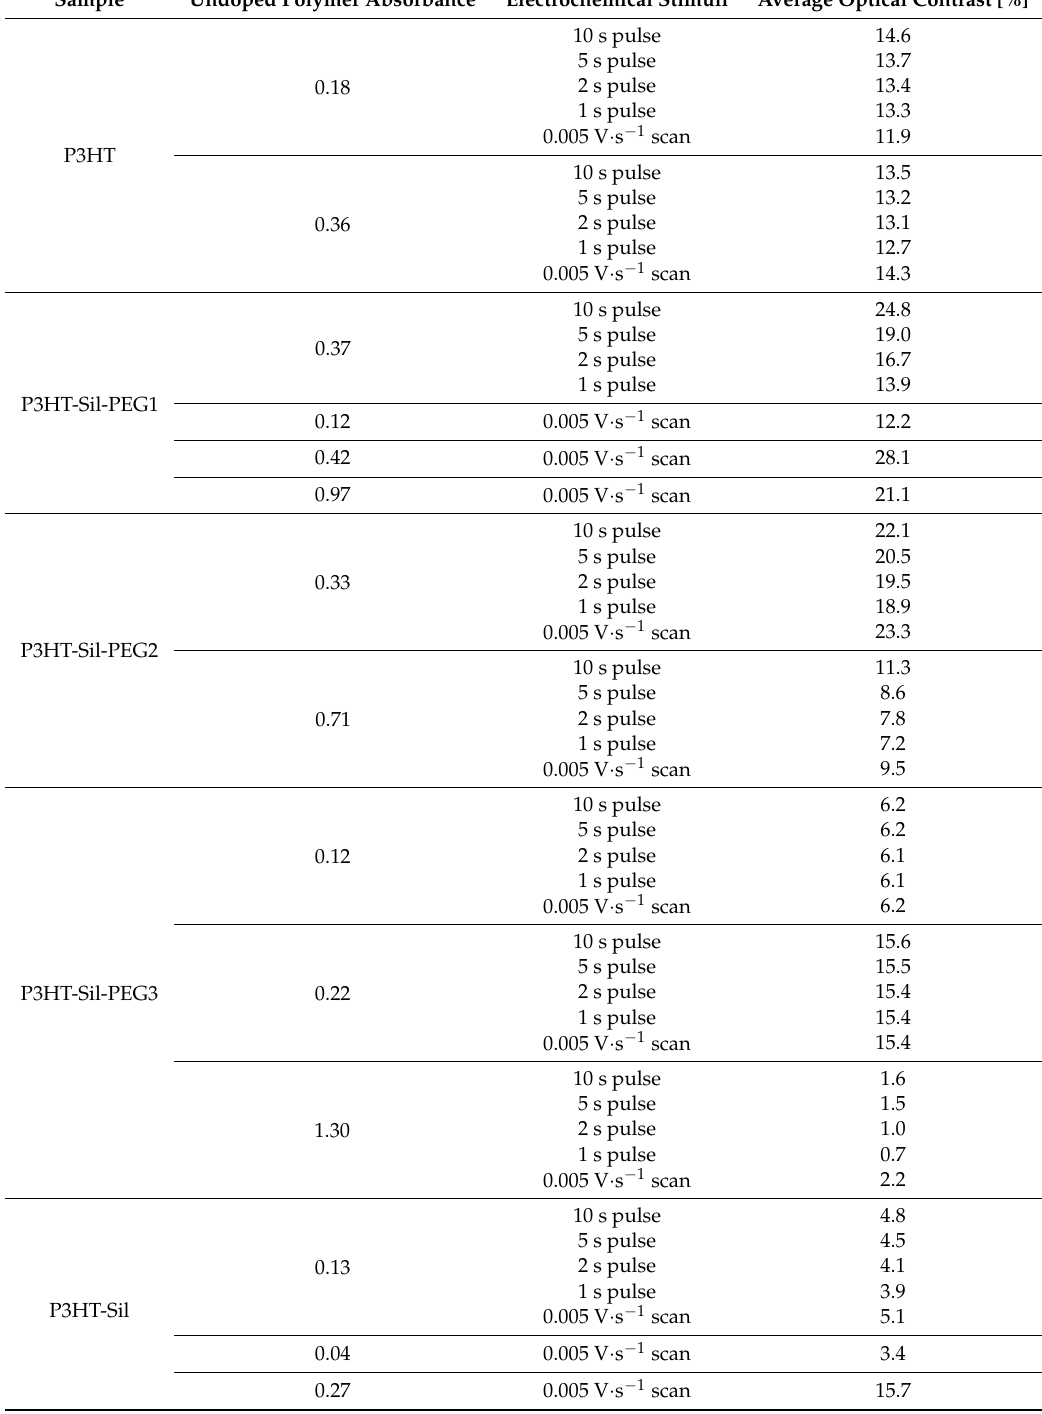
Table 2. Contrasts (given as the absolute value of transmittance differences between the undoped and doped states) achieved for films of varying thickness deposited using the investigated macromolecules, by utilising different types of electrochemical